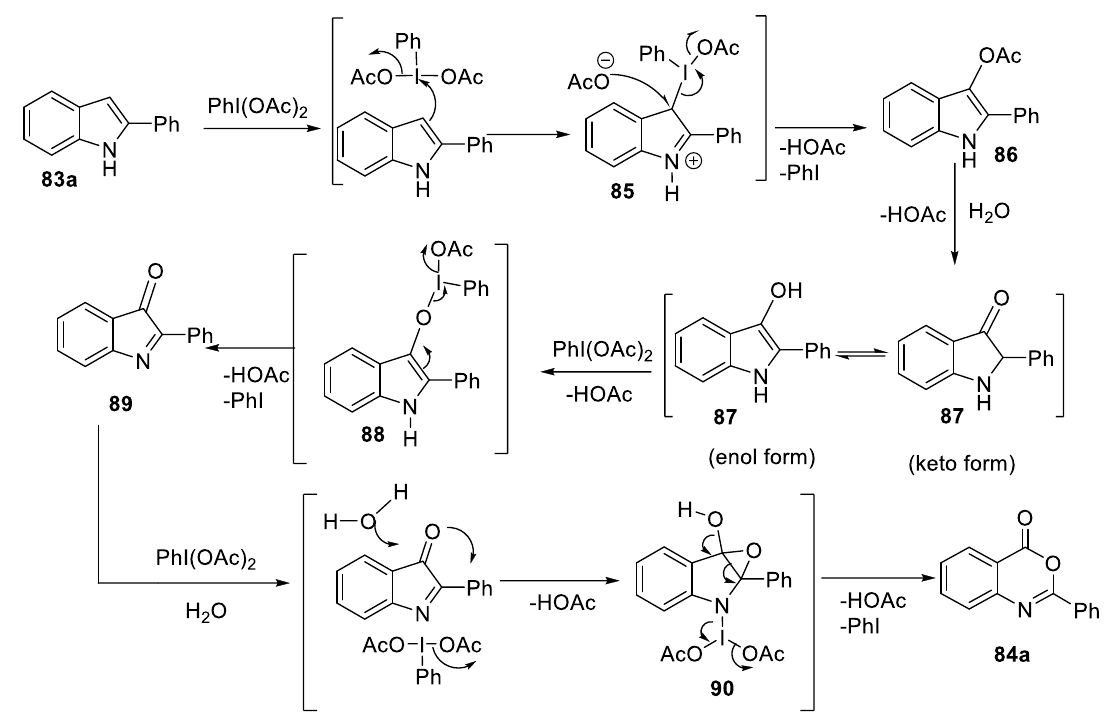
Figure 13. Proposed mechanism for PIDA-mediated oxidative reaction.